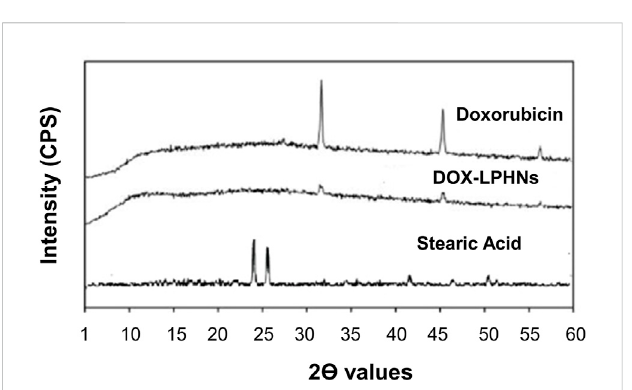
PowderX-RAYDiffractionofDOX,DOX-LPHNs-4,andStearicacid.